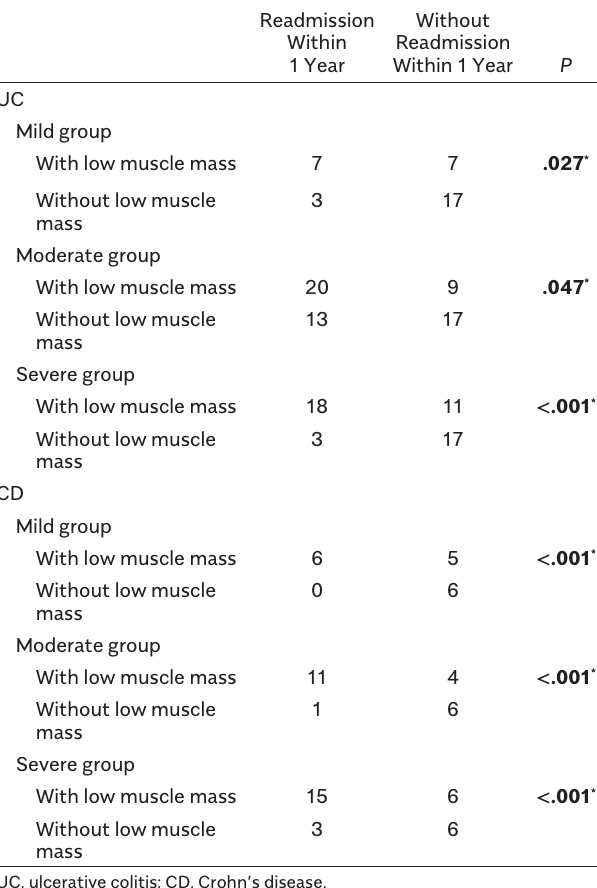
Table 5. Relationship of UC, CD Patients and Readmission Within 1 Year in Mild, moderate, and Severe